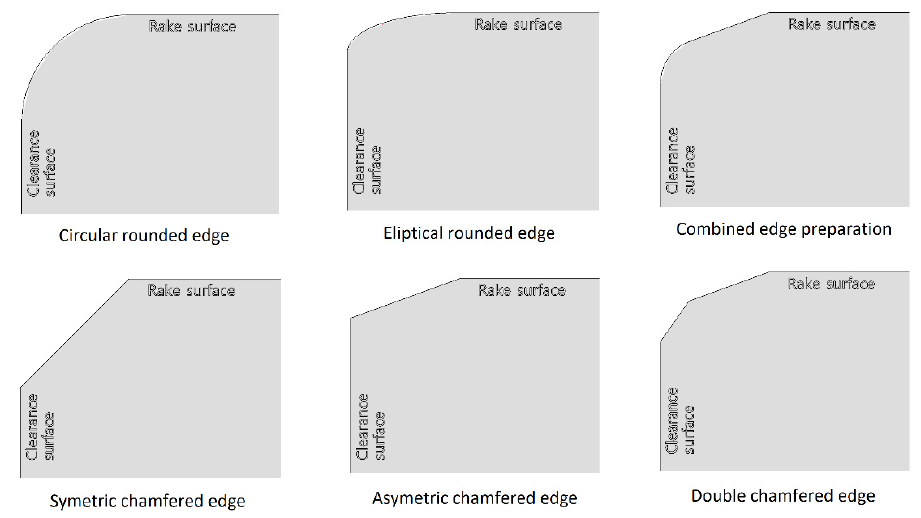
Figure 1. Typical geometries of cutting-edge preparation [16].